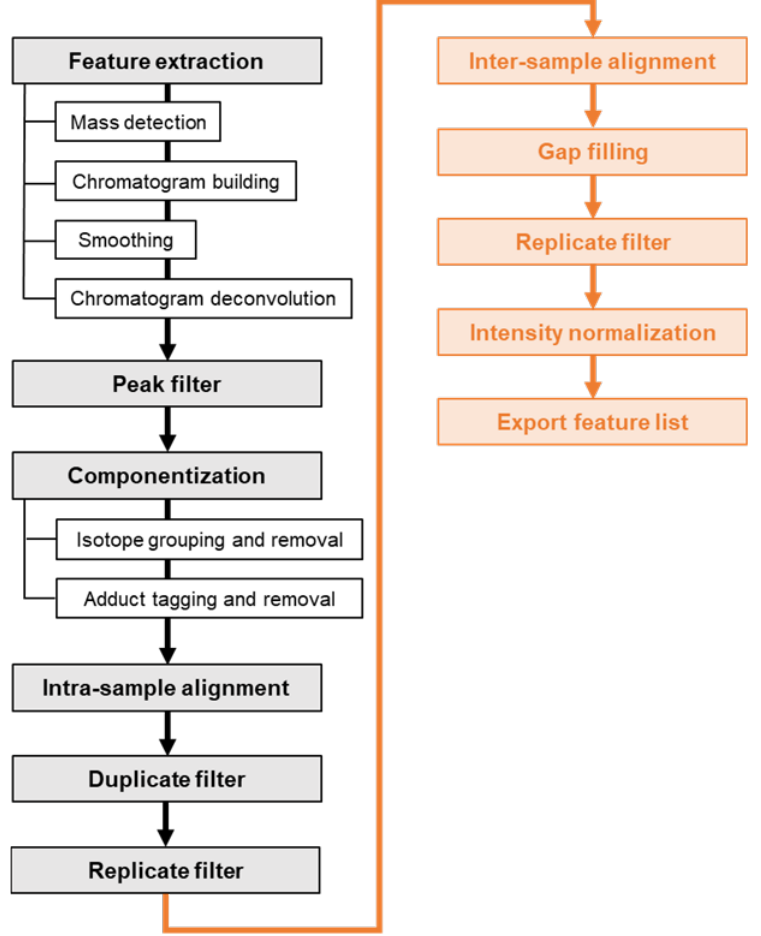
Figure 5. NTS data processing workflow for comparing a treated and an untreated surface water sample. The processing steps for extracting and filtering features from the technical replicates of a single sample are depicted in black. The orange boxes are processing steps that enable the comparative analysis of the treated and the untreated sample.